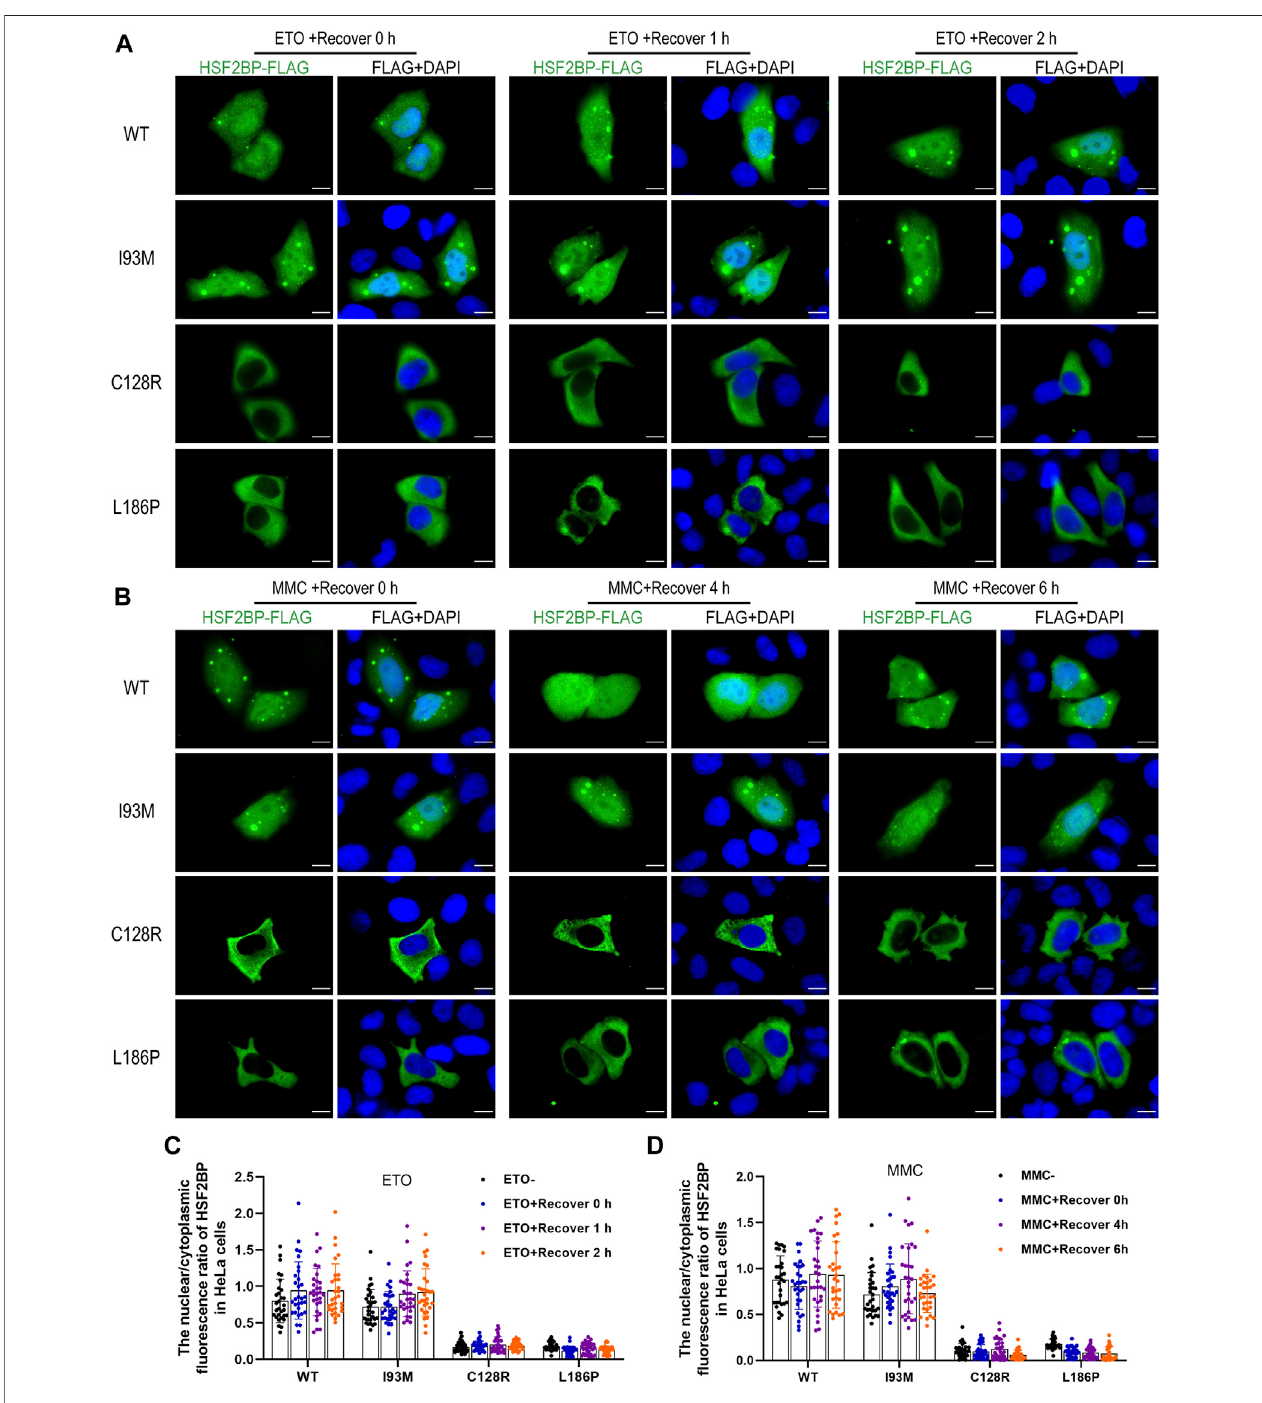
FIGURE 3 | The disturbed nuclear localization of mutant HSF2BP was not affected by DNA damaging agents. (A,B) Immuno fl uorescence against FLAG (green) in HeLa cells overexpressing wild-type (WT) or mutant HSF2BP (I93M, C128R, and L186P) plasmids with etoposide (ETO) (A) or mitomycin (MMC) (B) treatment. The nuclei were counterstained with DAPI (blue). Scale bars are 10 μ m. (C,D) The nuclear vs. cytoplasmic ratio of HSF2BP proteins in HeLa cells with ETO (C) or MMC (D) treatment and recovery at speci fi c time points.